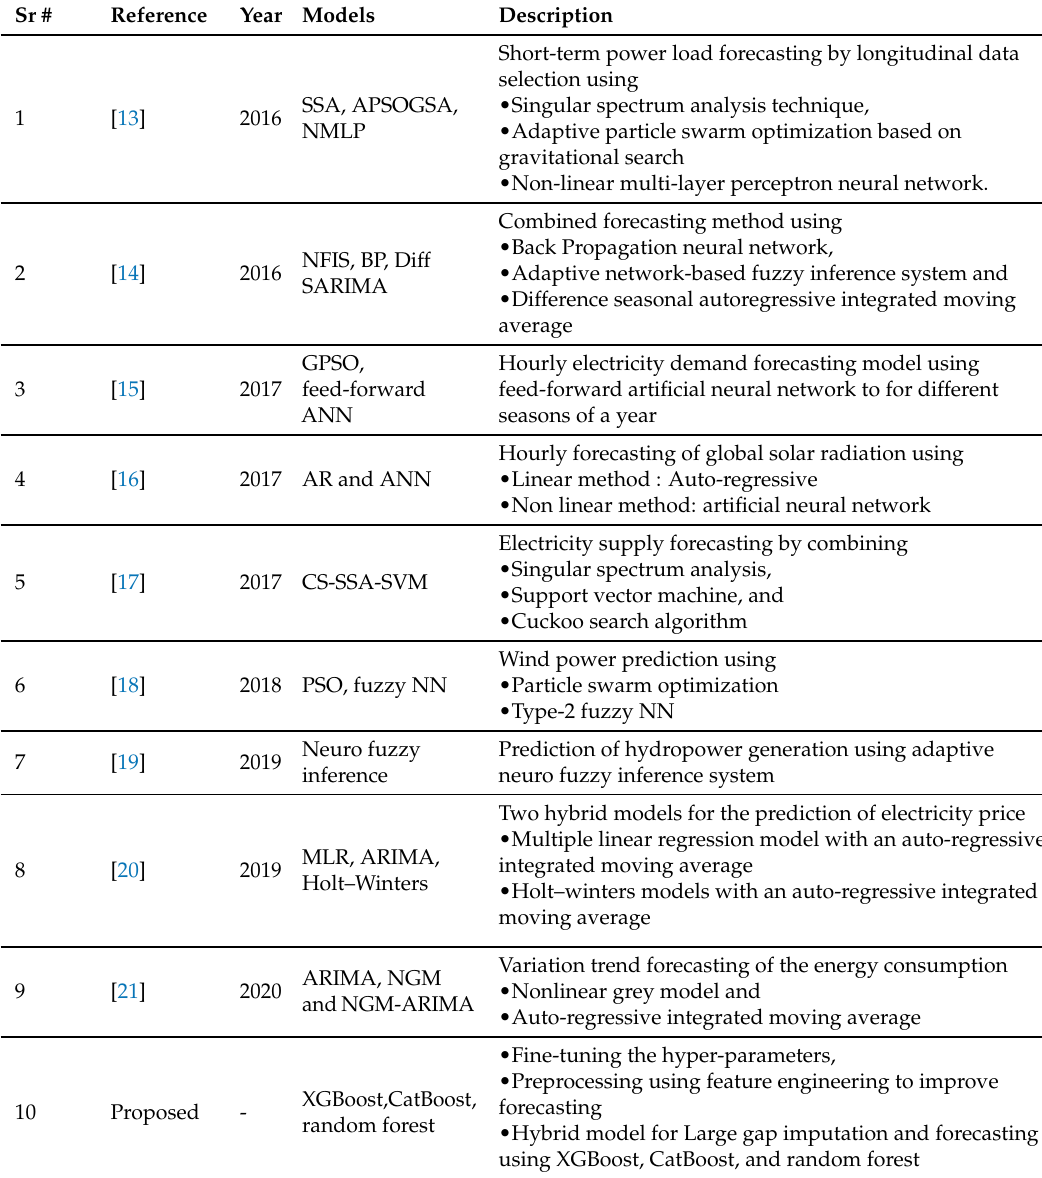
Table 1. ML-based hybrid models for